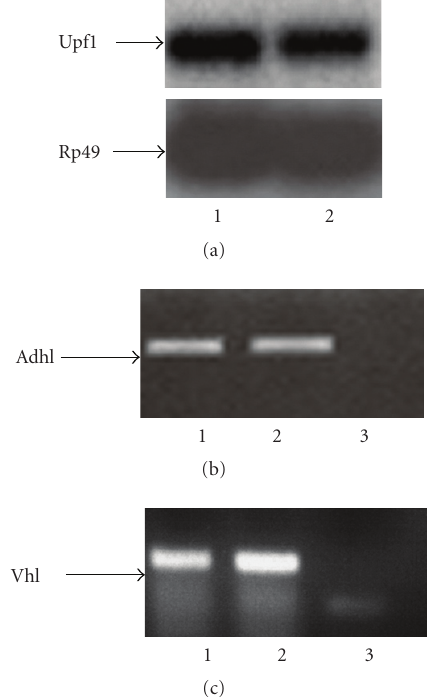
Figure 4: Upf1 , Adh, and Vhl expression in Drosophila testes and ovaries. (a) Northern blot analysis of poly (A+) RNAs isolated from wild type adult flies. Lane 1 : poly(A+) RNA from ovaries of adult females; lane 2 : poly(A+) RNA from testes of adult males. Arrowheads on the left mark the position of the detected